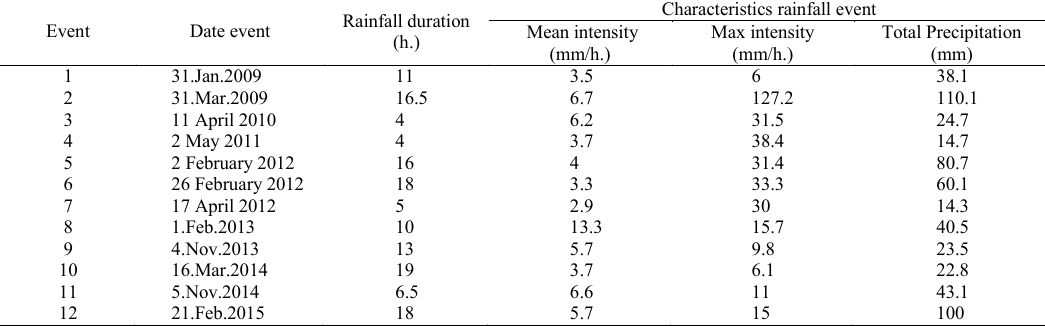
Table 3: Characteristics of rainfall events (2008-2015)